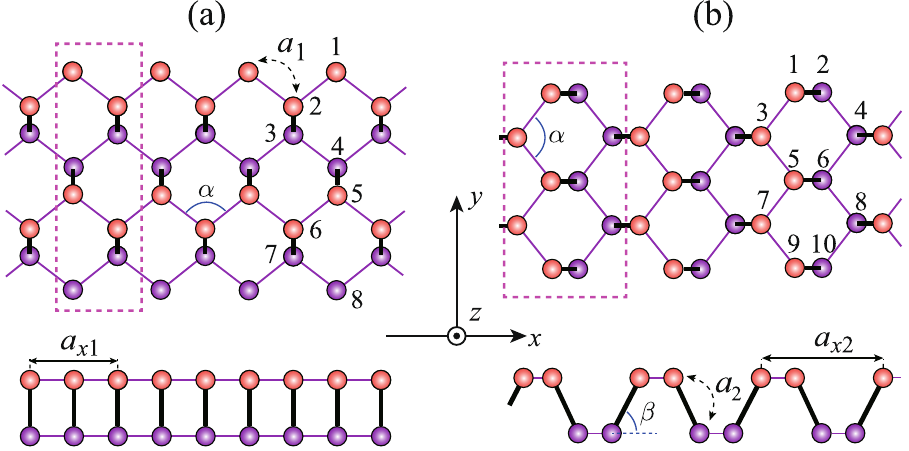
Figure 1. Top and side views of ( a ) 4z-Q1D-PNR and ( b ) 5a-Q1D-PNR. The orange and blue balls represent the upper-plane phosphorus atoms and the lower-plane ones. Unit cells are pointed out in the dashed blanks. Phosphorus atoms on the edges are all H-passivated.